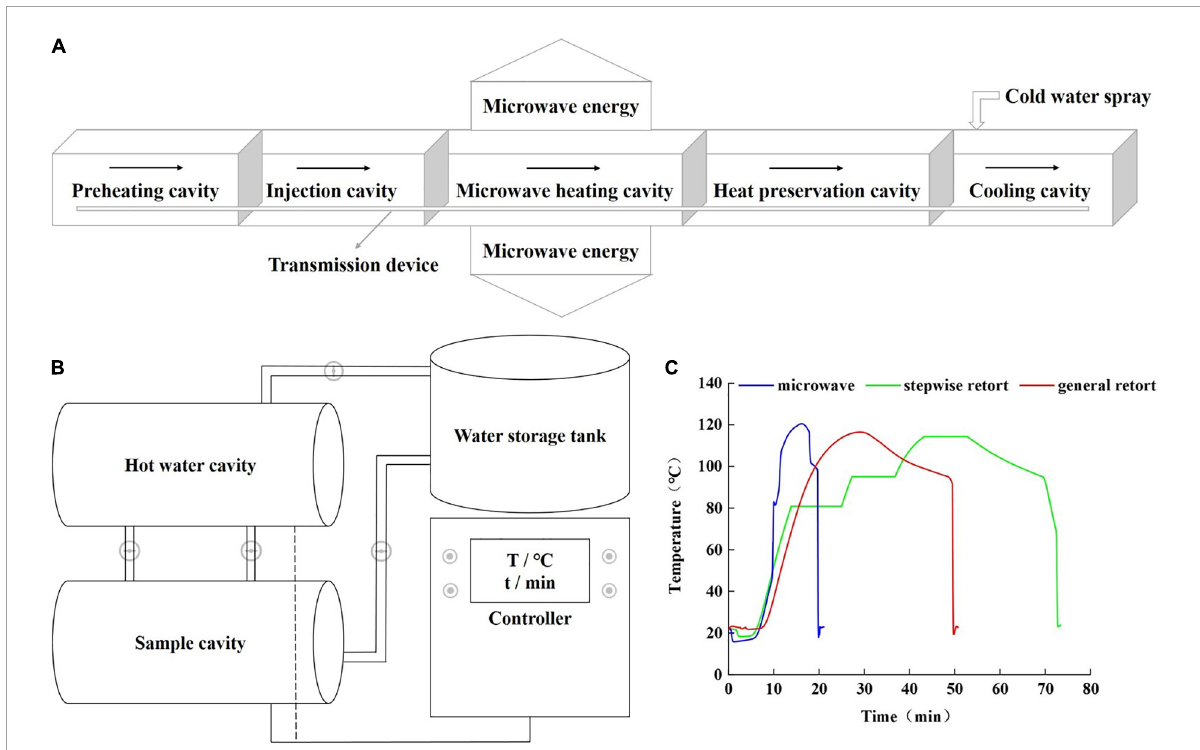
FIGURE1 Schematic diagram of microwave treatment (A) , schematic diagram of stepwise retort and general retort treatments (B) , and temperature curves monitored by the apparatuses at the cold point of the samples (C) . Stepwise retort heating and general retort heating were performed at a progressive three-temperature (80–95–115 ◦ C) and a constant temperature (121 ◦ C)